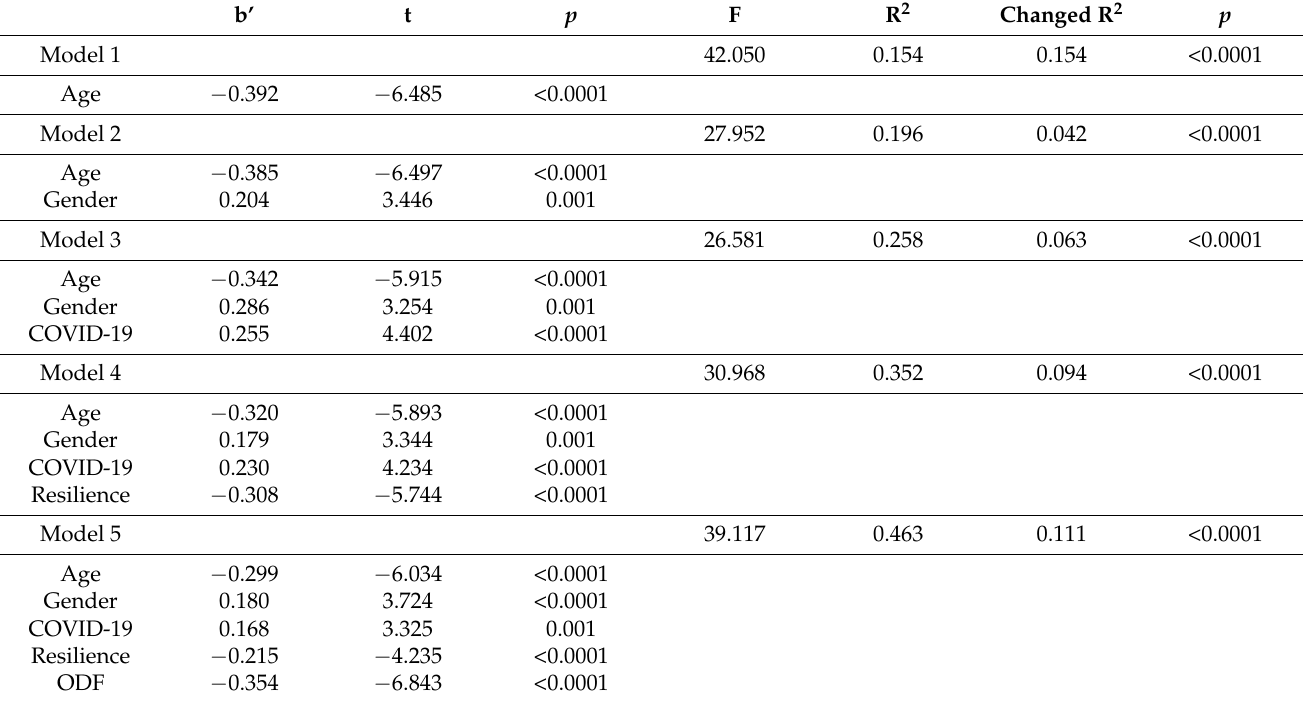
Table 4. Hierarchical regression analysis of predictors of perceived stress ( N =